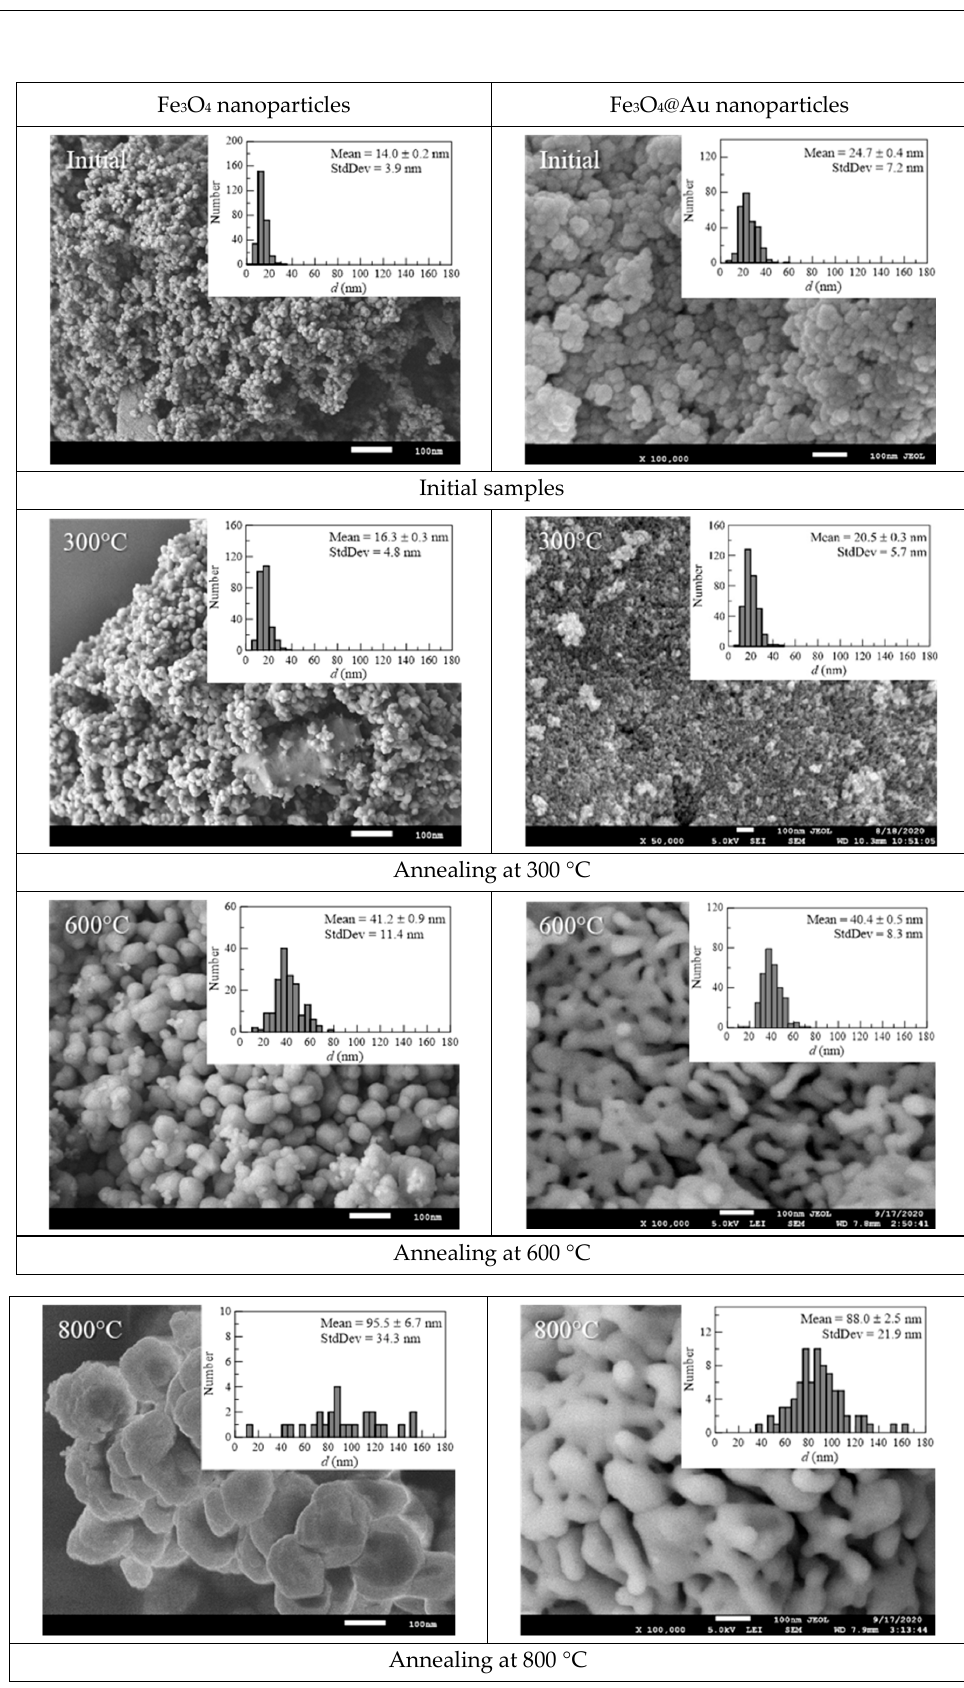
Figure 1. SEM images and size distributions of the studied Initial (initial samples) and Annealed (annealing at t ann ) Fe 3 O 4 and Fe 3 O 4 @Au nanoparticles.